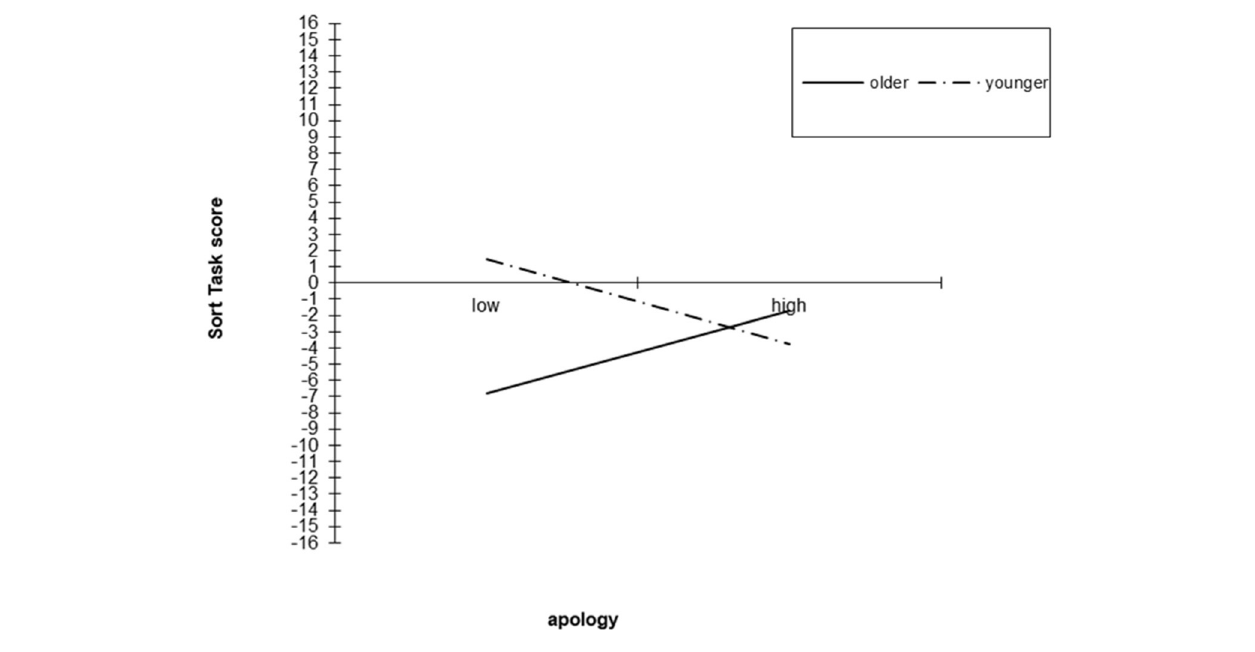
FIGURE 2 | Interaction between apology and age in predicting the Sort Task, Study 1.